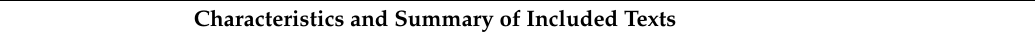
Table 1. Characteristics and summary of included